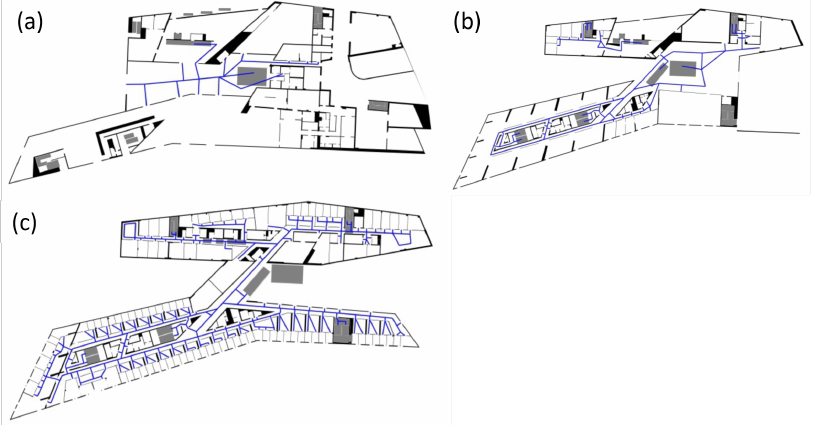
Figure 6. Floor plans of the ground floor ( a ), 1st floor ( b ), and 4th floor ( c ), with the blue lines representing the routing